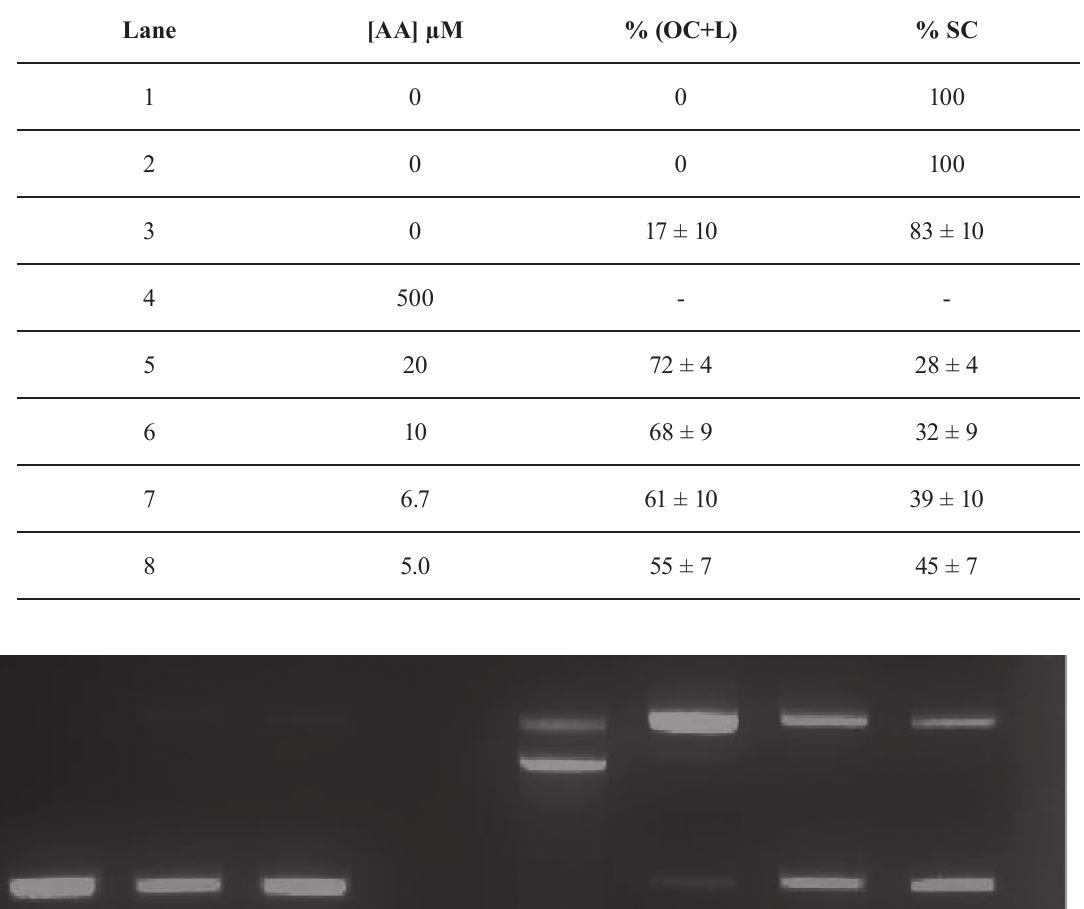
TABLE III – % of (OC+L) and SC forms of pUC-19 DNA 5.0 ng μL -1 according to the experimental conditions described in Figure 4